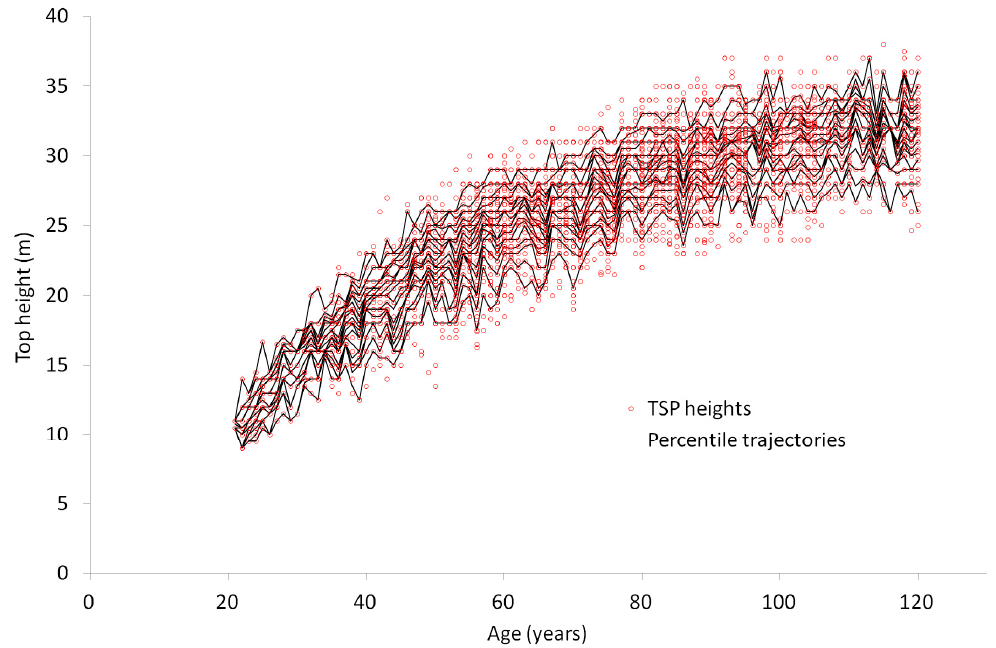
Figure 2. Top heights of individual temporal sample plots and 19 artificial growth trajectories obtained by joined percentiles (5, 10, ..., 95) of heights in particular years.